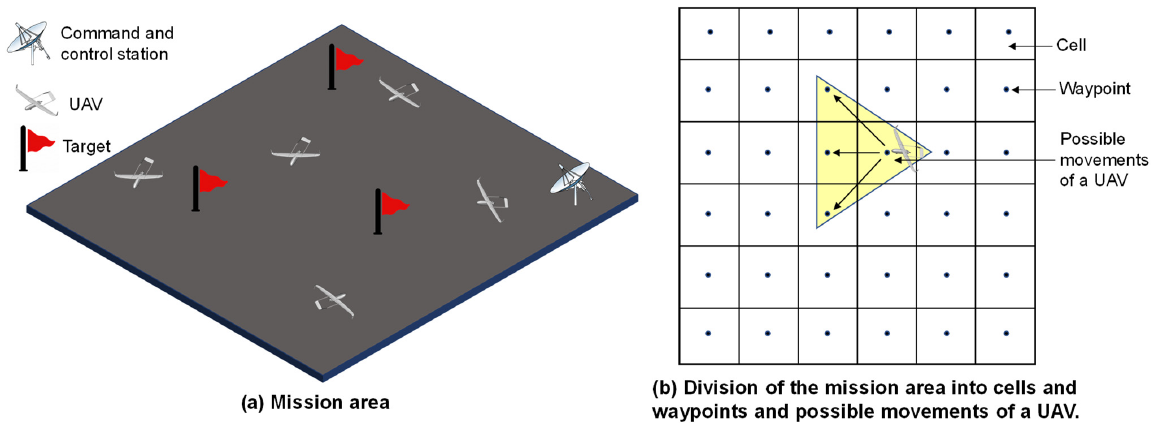
Figure 1. Illustration of the considered problem scenario: ( a ) the mission area and ( b ) the division of the mission area into cells and waypoints and the possible movements of a UAV.